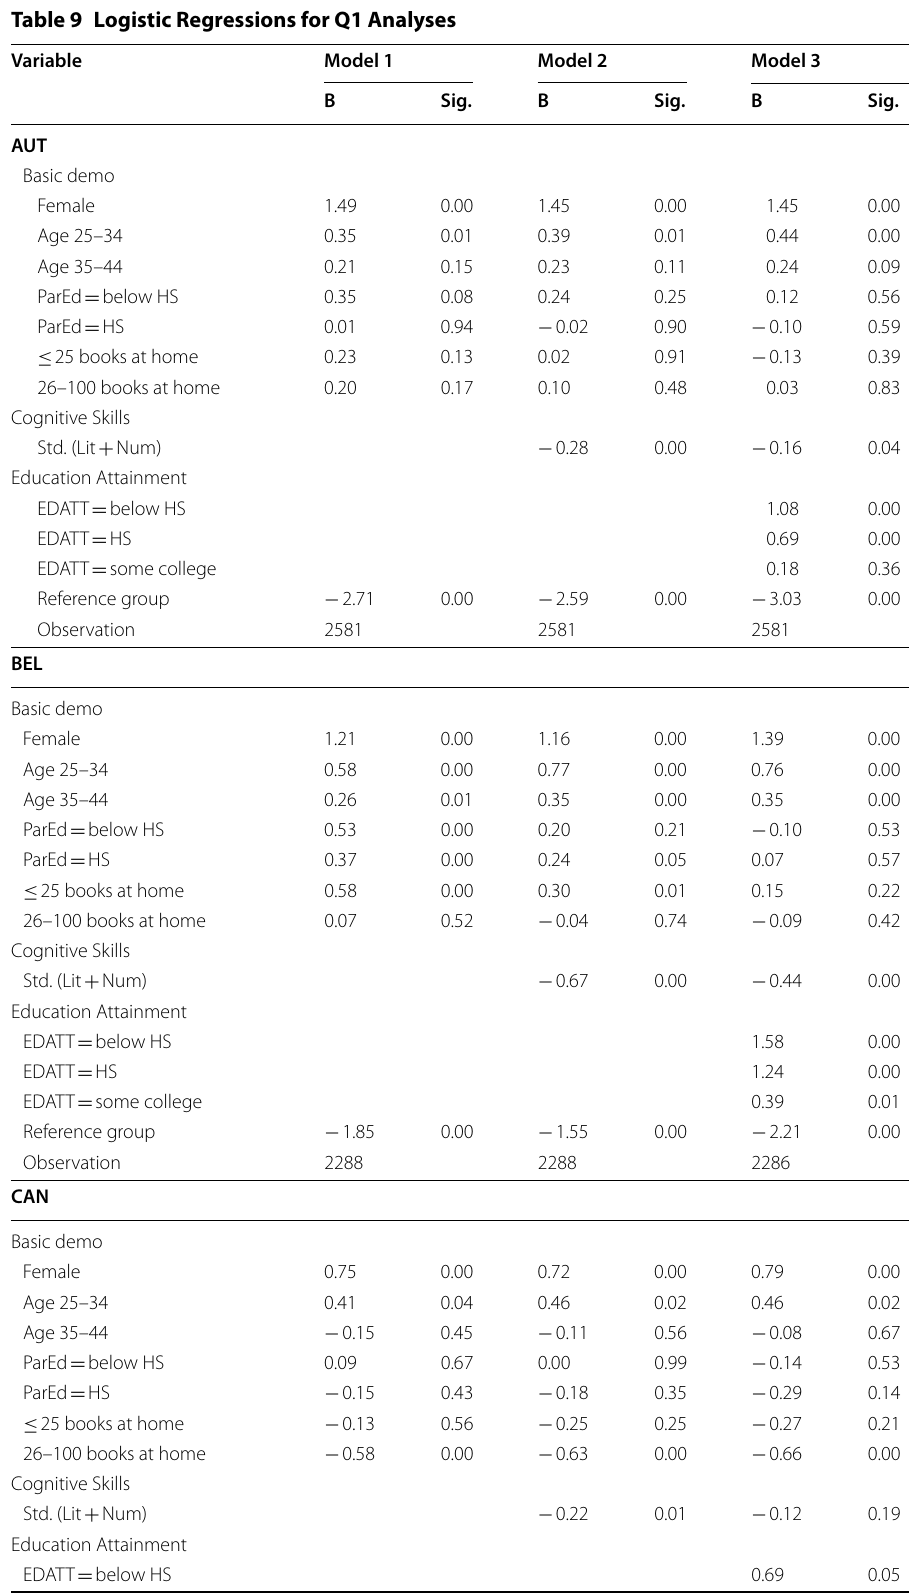
Table 9 Logistic Regressions for Q1